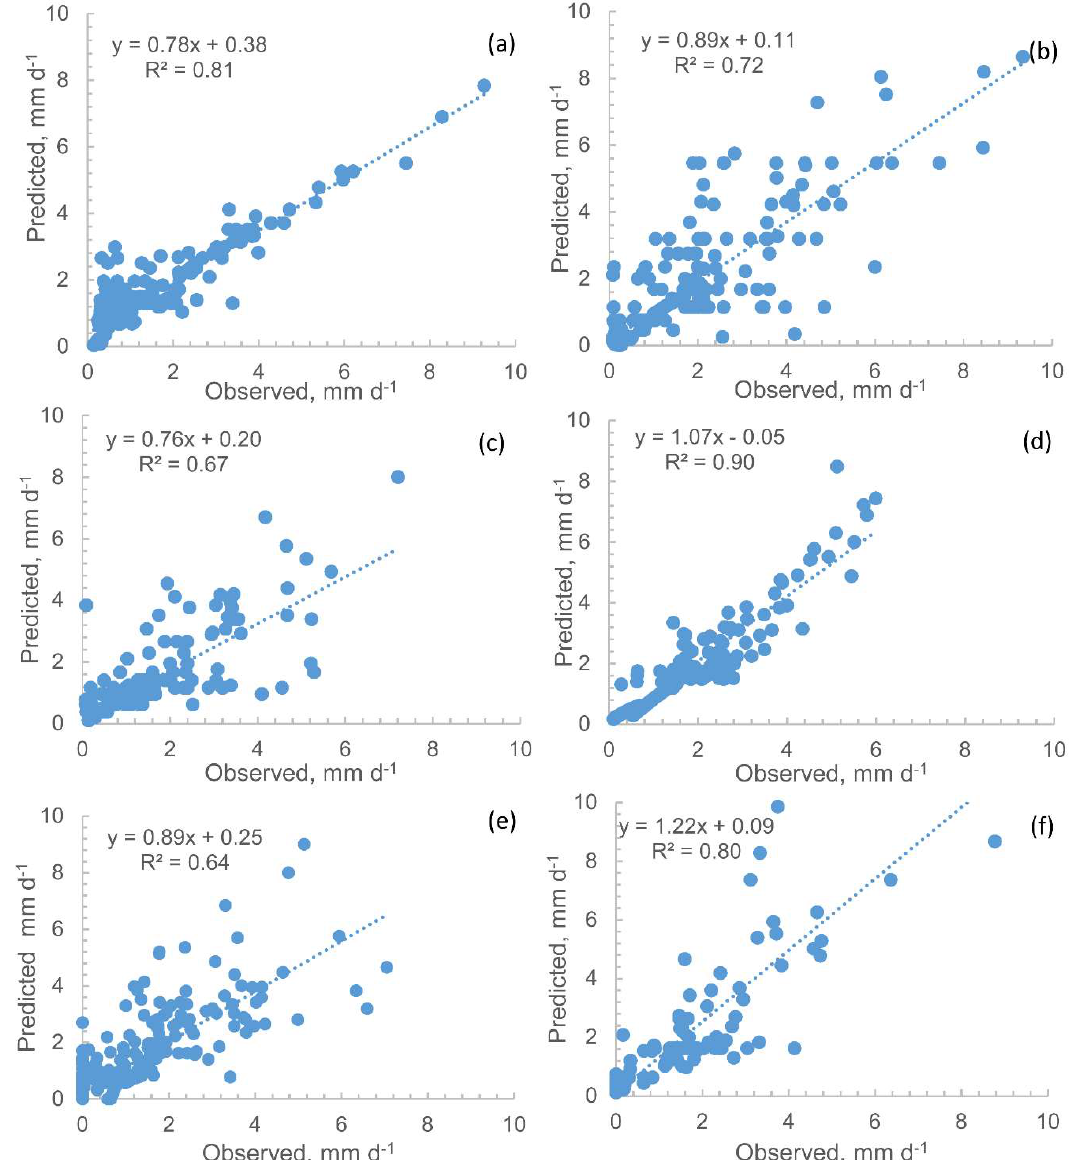
Figure 4. Observed and PED model predicted daily discharge of the Tikur-Wuha watershed from 2010 to 2015: ( a ) 2010; ( b ) 2011; ( c ) 2012; ( d ) 2013; ( e ) 2014; ( f ) 2015.